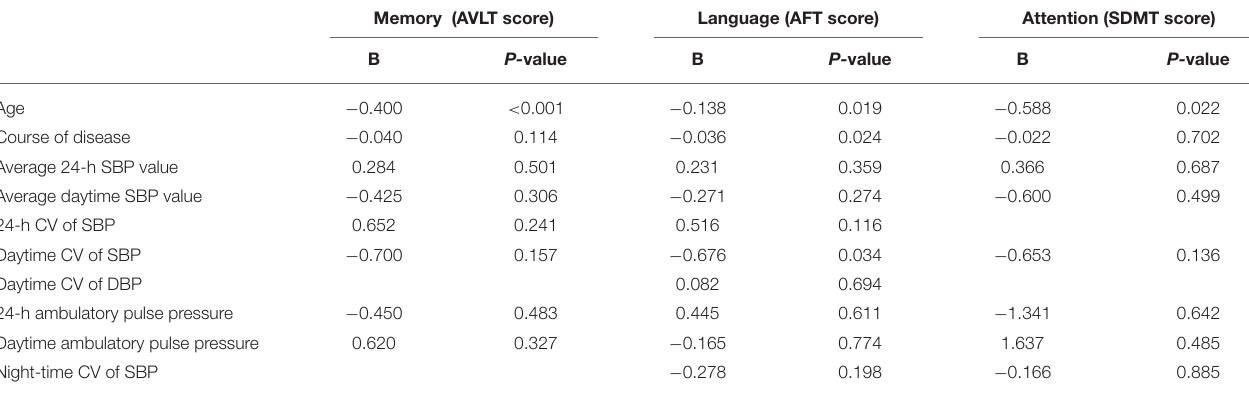
TABLE 4 | Multivariate regression analysis of cognitive domain scores in patients with